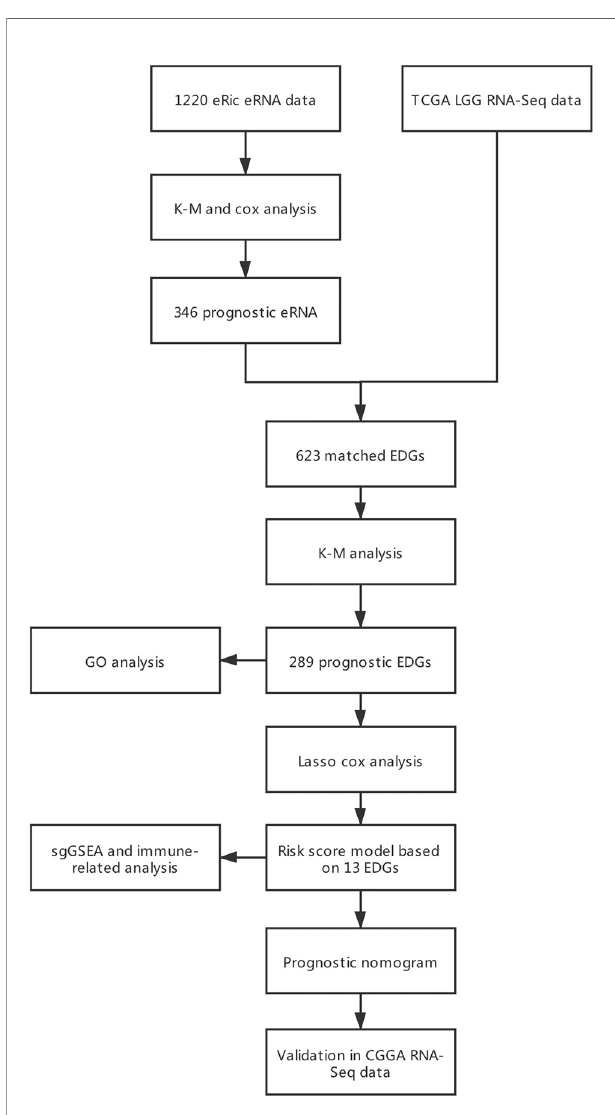
FIGURE 1 | Flowchart of developing and validating the EDGs prognostic